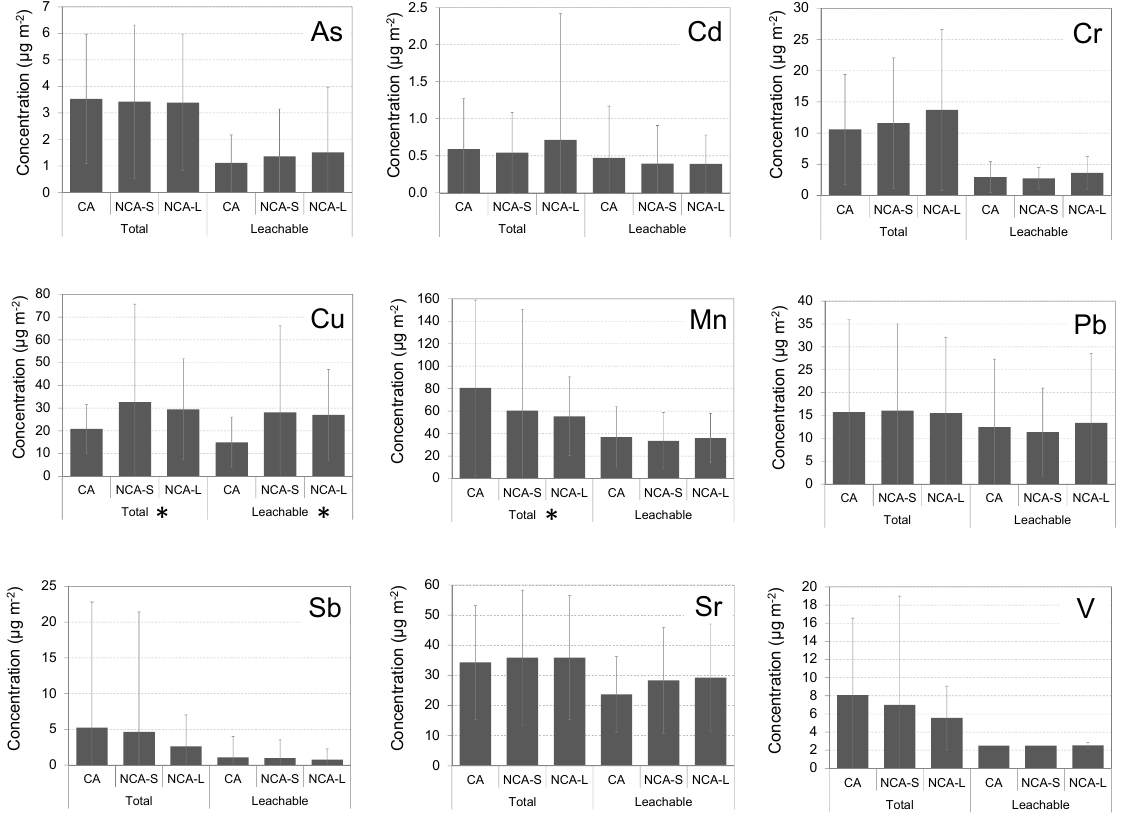
Figure 4. Mean metal loadings (total and leachable; μ g·m − 2 ) per sampling location. CA: Crossing area; NCA-S: Non-crossing area with dust accumulated over short periods; and NCA-L: Non-crossing area with dust accumulated over long periods. *: Denotes a significant difference within a group according to Friedman test results ( p -value <